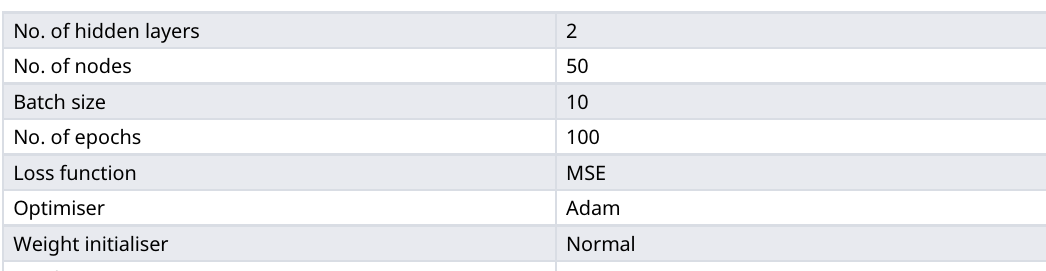
Table 4. Optimum parameters.